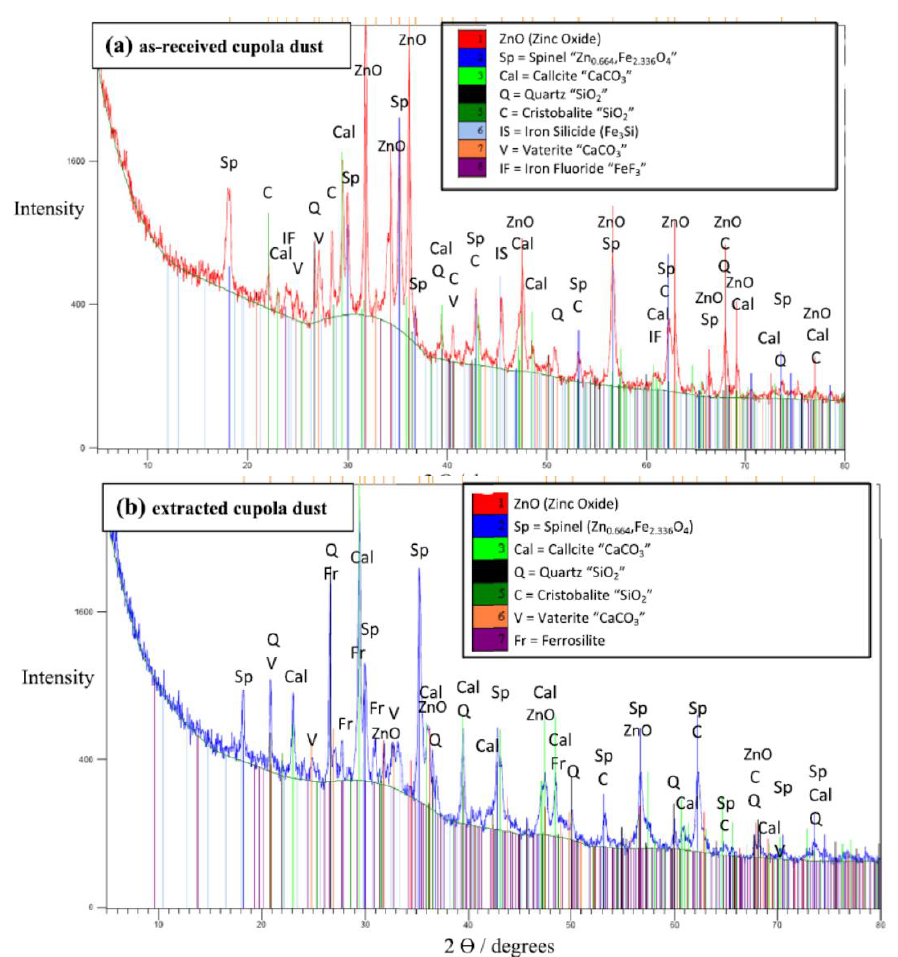
Figure 9. X-ray diffraction (XRD) pattern of ( a ) as-received cupola dust and ( b ) dust residue after extraction from DES.